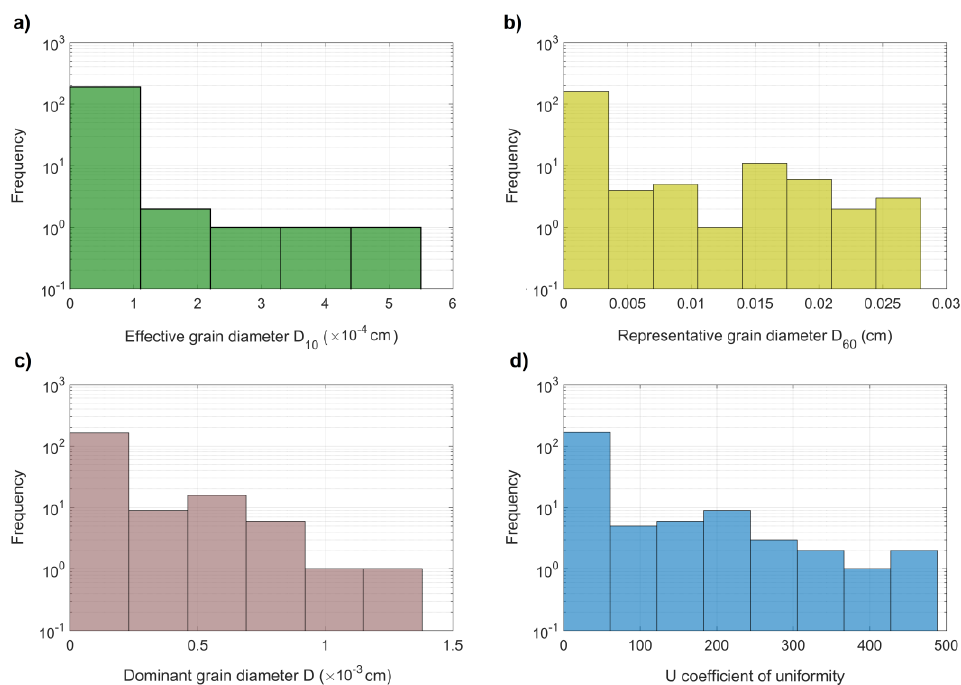
Figure 11. Histograms of grain sizes derived by sieve analysis: ( a ) relative occurrence of effective grain diameter data; ( b ) relative occurrence of effective grain diameter data; ( c ) relative occurrence of dominant grain diameter data; ( d ) relative occurrence of uniformity coefficient data in Baktalórántháza-1 well.